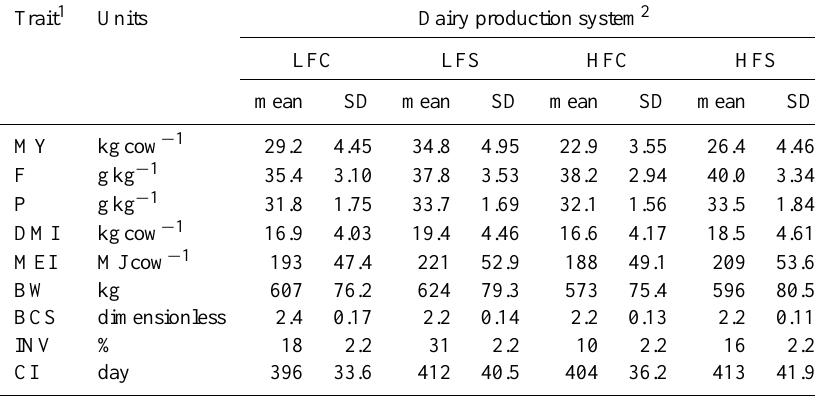
Table 2. Descriptive statistics for performance traits of lactating cows in Langhill systems. Trait 1 Units Dairy production system 2 LFC LFS HFC HFS mean SD mean